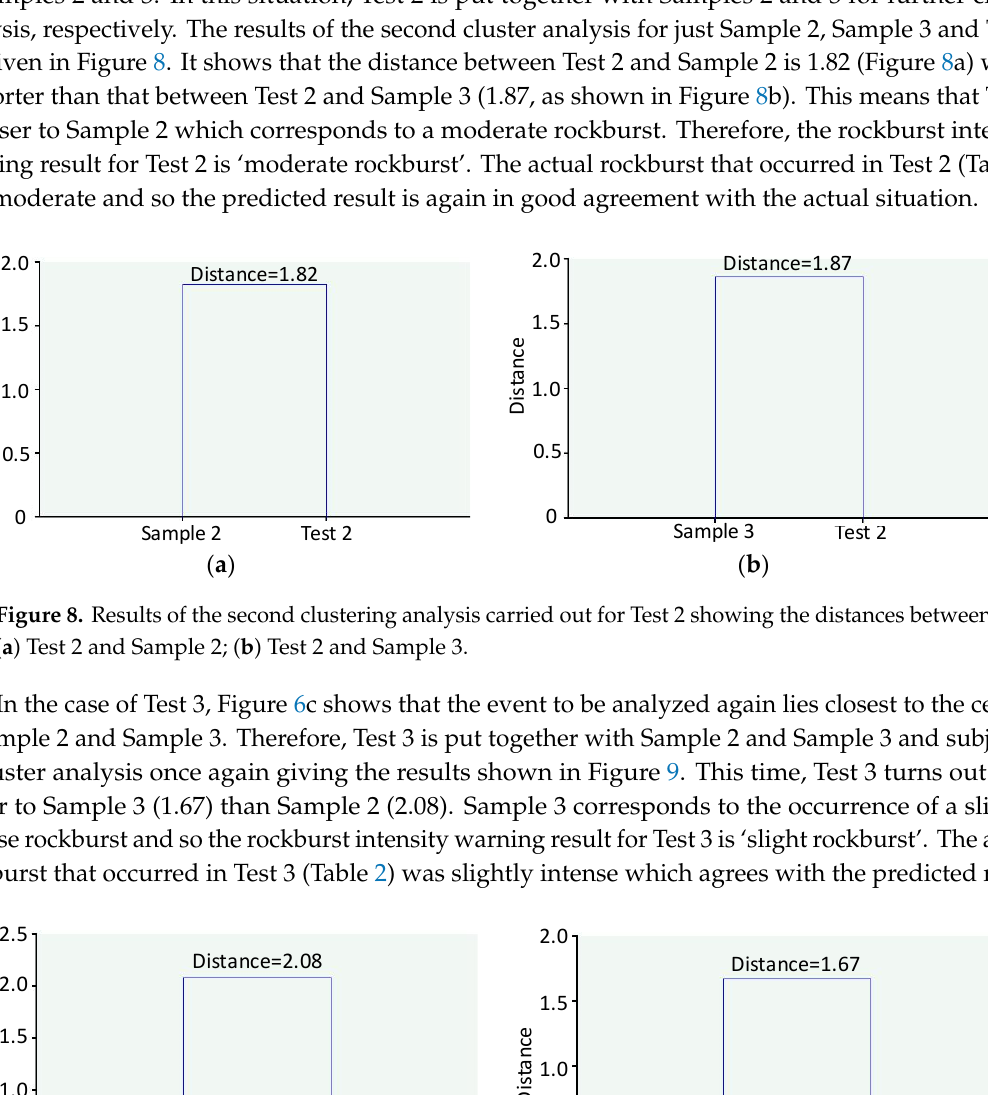
Figure 8. Results of the second clustering analysis carried out for Test 2 showing the distances between: ( a ) Test 2 and Sample 2; ( b ) Test 2 and Sample 3.